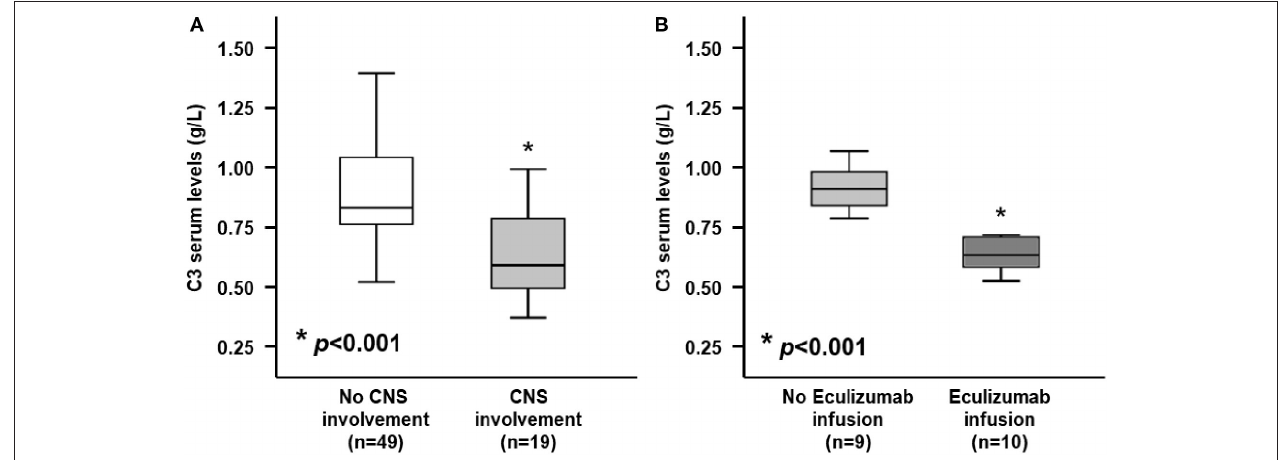
FIGURE 2 | Serum C3 levels at admission between STEC-HUS patients depending on central nervous system (CNS) involvement and Eculizumab infusion. (A) At hospital admission, patients who would develop neurologic involvement (light gray box), showed significantly lower serum C3 levels, as compared with those who would not develop neurologic involvement (white box) (0.65 ± 0.19 vs. 0.90 ± 0.22 g/L; p < 0.001). (B) Among patients who would develop neurologic involvement, those who needed rescue therapy with Eculizumab (dark gray box) showed significantly lower C3 levels, as compared with those who did not need it (light gray box) (0.50 ± 0.08 vs. 0.82 ± 0.11 g/L; p < 0.001). Mann-Whitney U -test for non-parametric data. Data in the graphs are expressed as median and 25th and 75th percentiles in boxes and 5th and 95th percentiles as whiskers. * p <